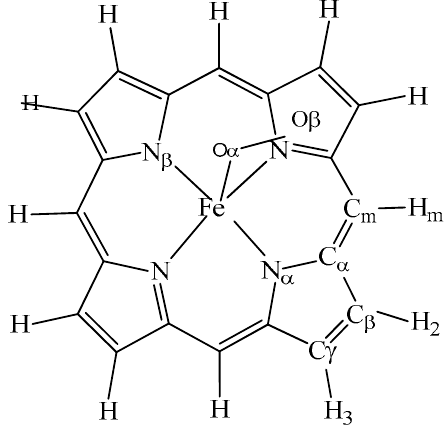
Figure 2. The geometric structure of intermediate.